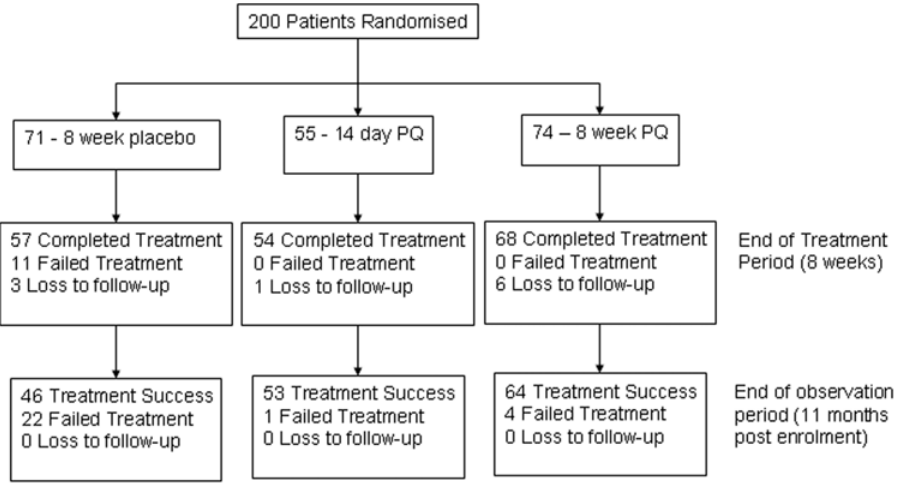
Figure 1. Patient flow through the trial at enrolment, end of treatment period (8 weeks) and end of follow-up (11 months).